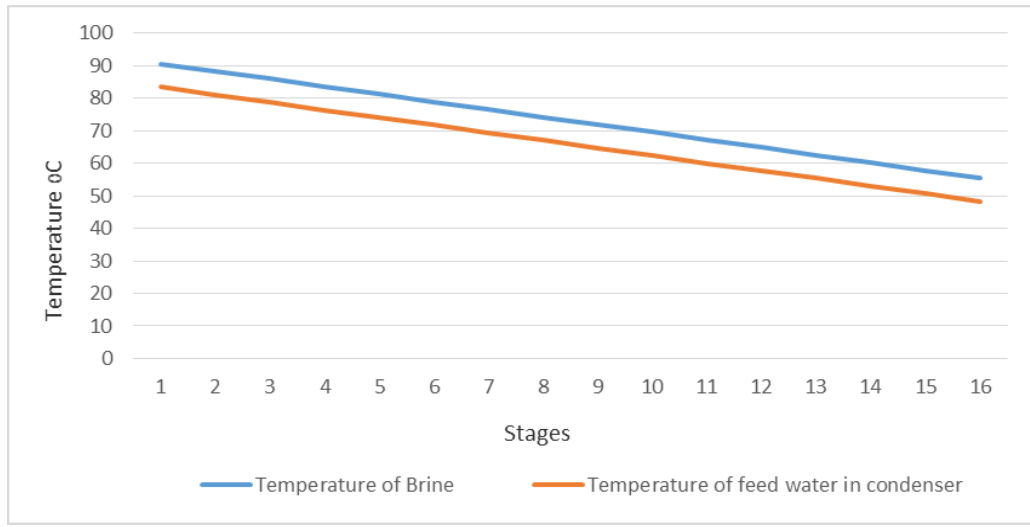
Figure 6. Temperature profile of the brine and intake seawater.